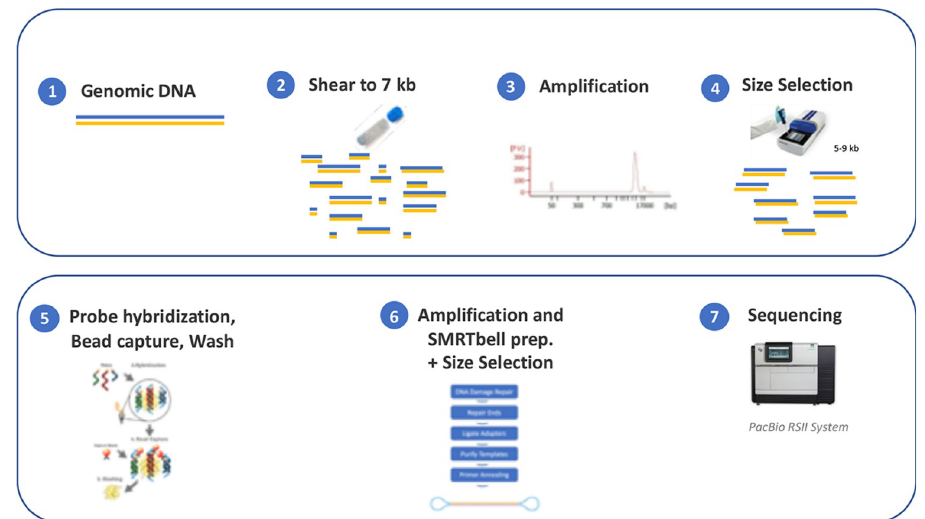
Fig 2. Overview of SeqCap 1 EZ probe-based capture and subsequent SMRT sequencing workflow. Genomic DNA was sheared into on average of 10Kb fragments followed by a ligation of adapters, amplification and size selection step using the BluePippin System. Next, the probes where hybridized, followed by bead capture and washing to remove any nonspecific and unbound molecules. Finally, the sequencing libraries were generated, size selected using BluePippin and loaded onto the PacBio RS II sequencing